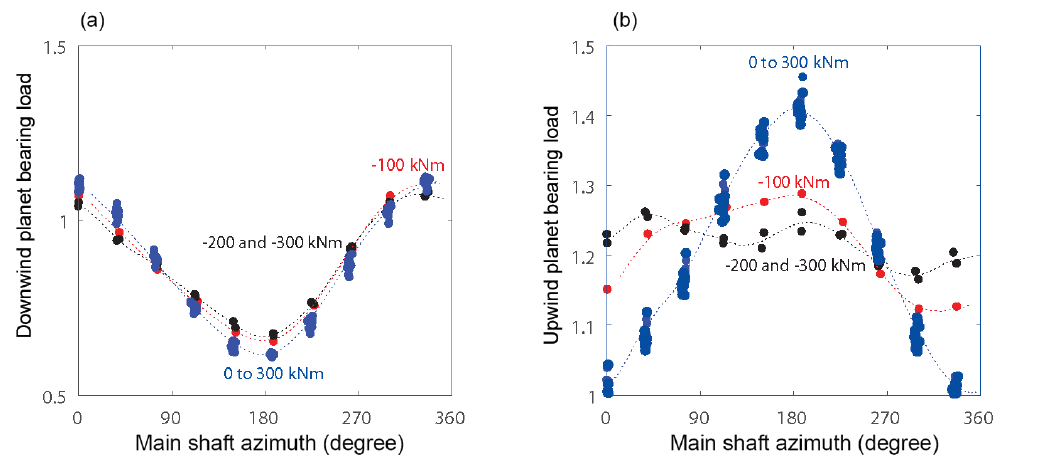
Figure 9. Upwind-measured (a) and downwind-measured (b) planet CRB